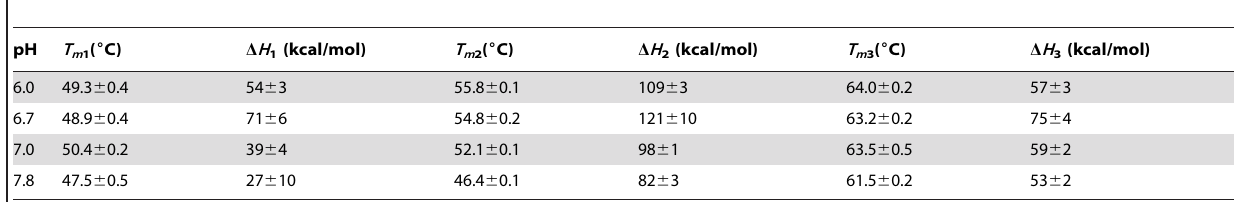
Table 3. Dependence on pH of thermal transitions under the DSC envelope of Cpl-7.